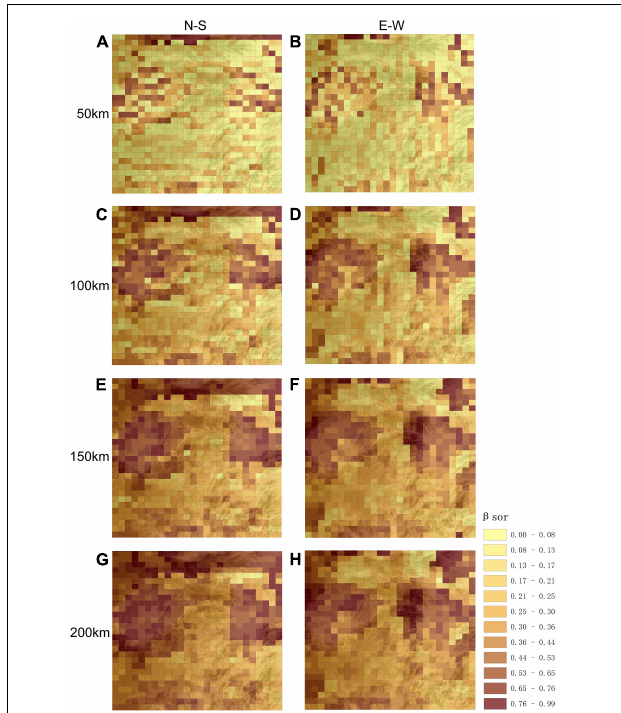
FIGURE 3 | Spatial patterns in β -diversity at different scales and for different directions. (A,C,E,G) Represent longitudinal directional β -diversity at 50, 100, 150, and 200 km respectively; (B,D,F,H) represents latitudinal β -diversity at 50, 100, 150, and 200 km respectively. The base graphic is a topographic